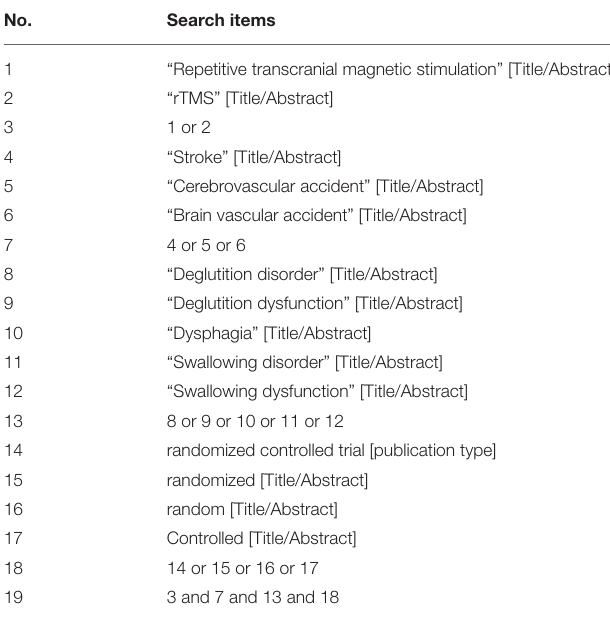
TABLE 1 | The specific search strategy of Pubmed